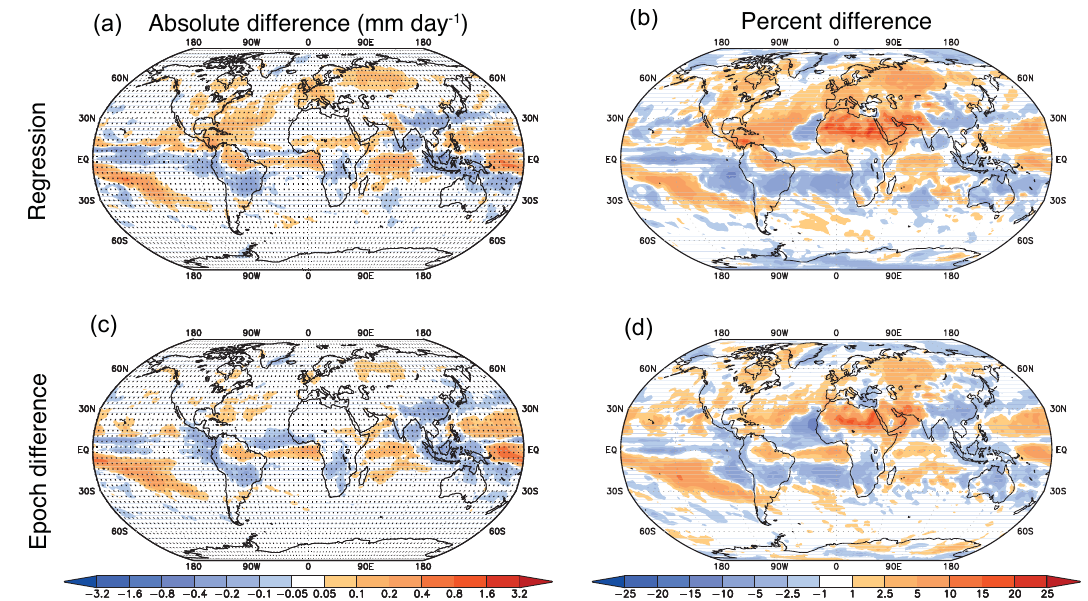
Figure 7. As in Fig. 3 but where the reconstruction ˆ B is built on the pattern P for the RCP8.5 simulation (group 1 average over years 227–251), and global mean temperature (cid:49) ¯ T is averaged over years 116–140 (1965–1990) of the historical/RCP8.5 simulation; i.e., ˆ B = P RCP8 . 5 ( x )(cid:49) ¯ T RCP8 . 5 (116–140). Results shown are for the difference between the reconstruction and the actual model output of the historical simulation ˆ B − B RCP8 . 5 ( x , 116–140).